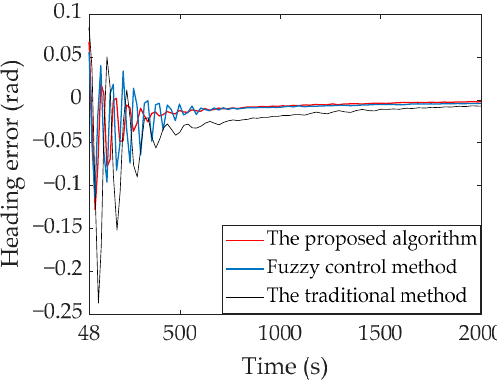
Figure 18. Cross-track position error for the Archimedean spiral.